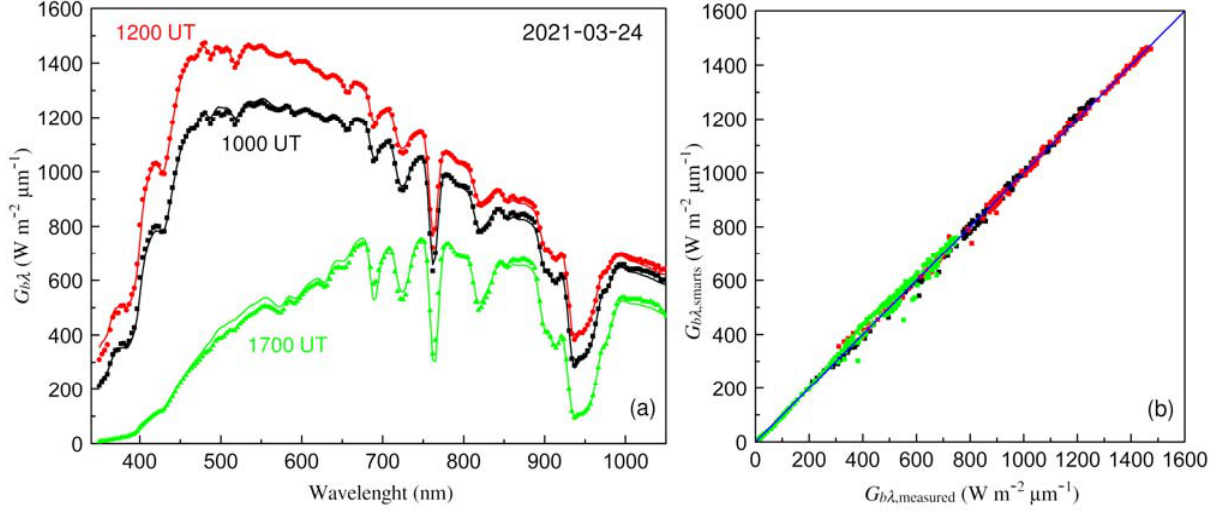
Figure 10. ( a ) Spectra measured with the EKO-MS700N spectroradiometer (dots) and estimated with SMARTS (lines) using the iterative procedure proposed here for the three instants of test day 24 March 2021 shown in Figure 9; ( b ) Estimated vs. measured spectral irradiance values corresponding to the same spectra considered in ( a ). The 1:1 diagonal of perfect fit is also shown.